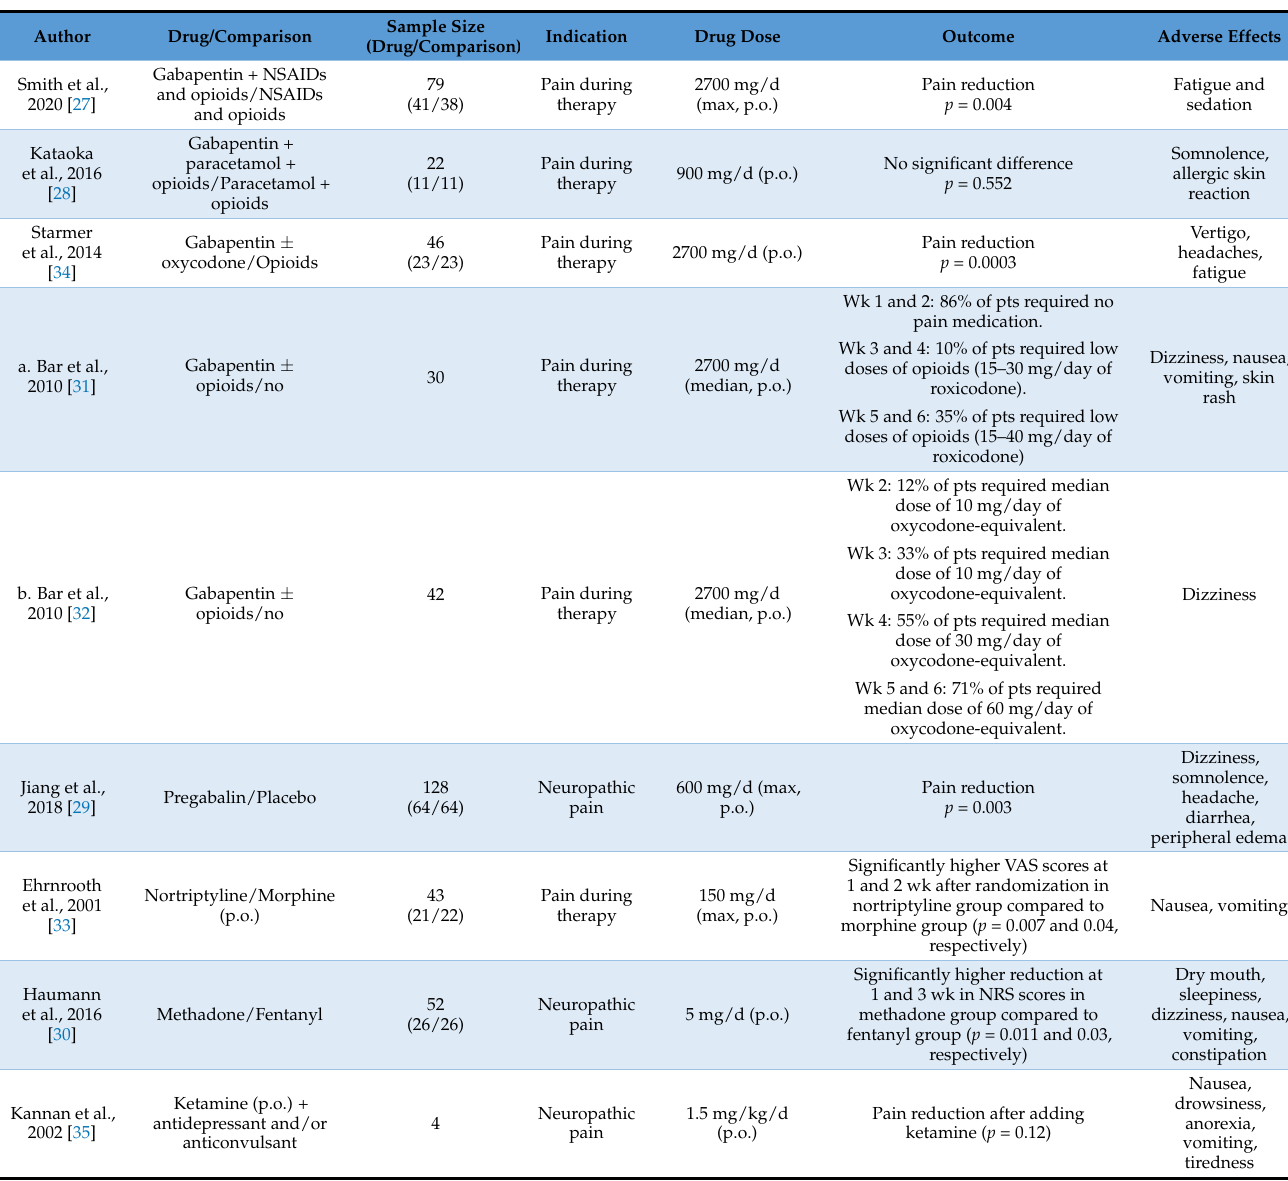
DizzinessWk 3: 33% of pts required median dose of 10 mg/day of